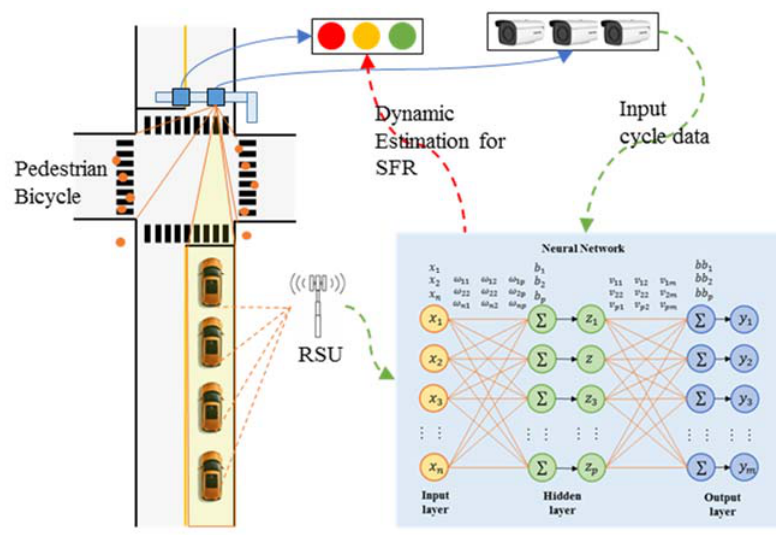
Figure 4. Application of neural network model at signalized intersection.